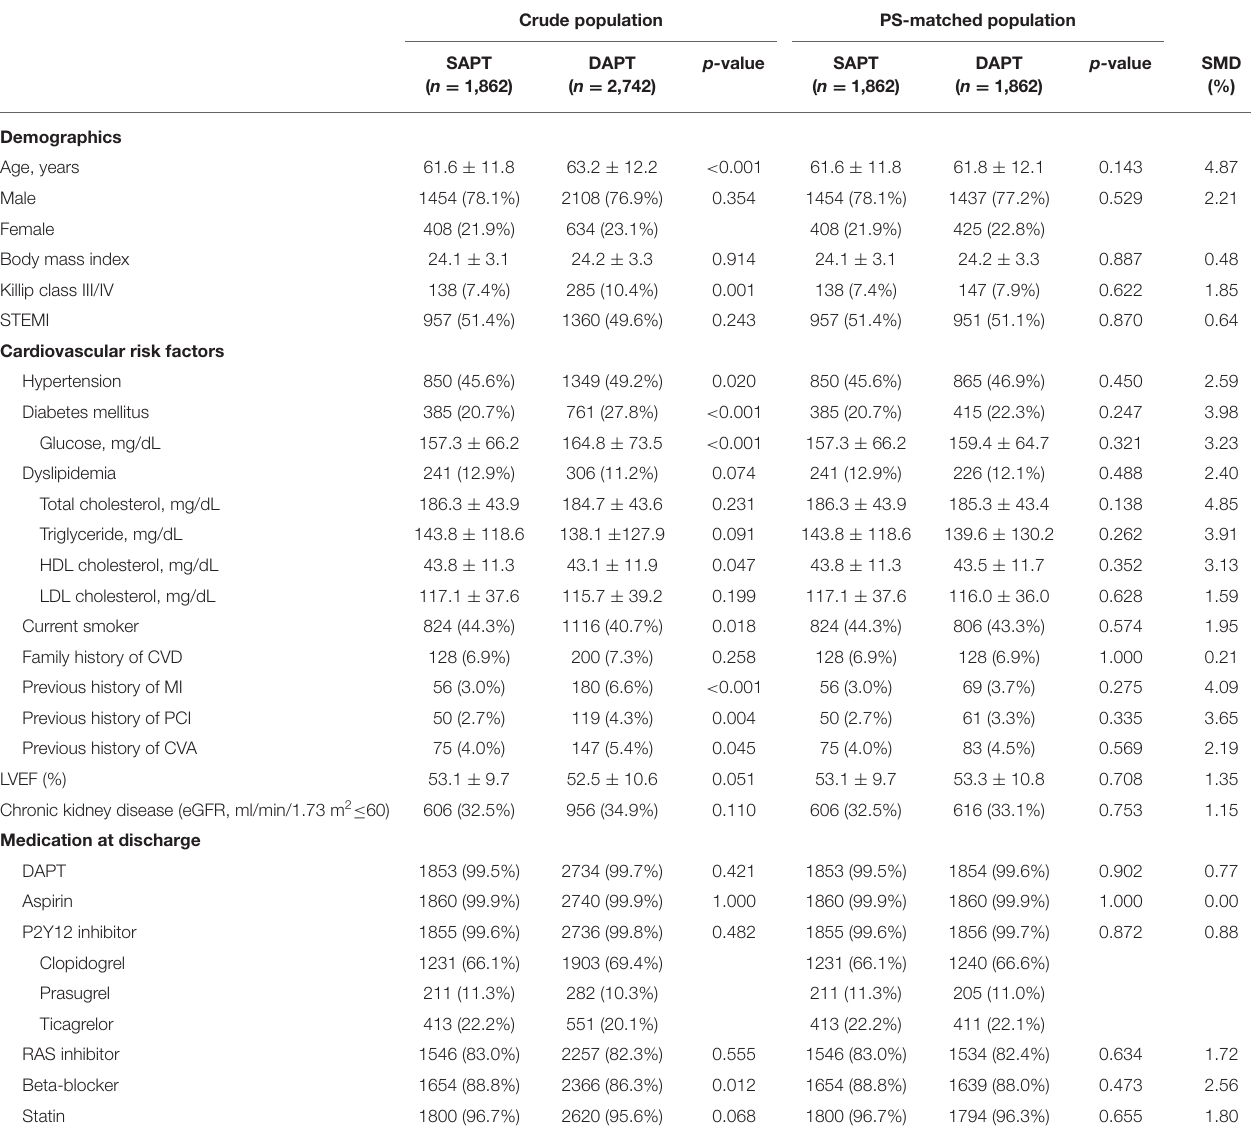
TABLE 1 | Baseline clinical characteristics of the study